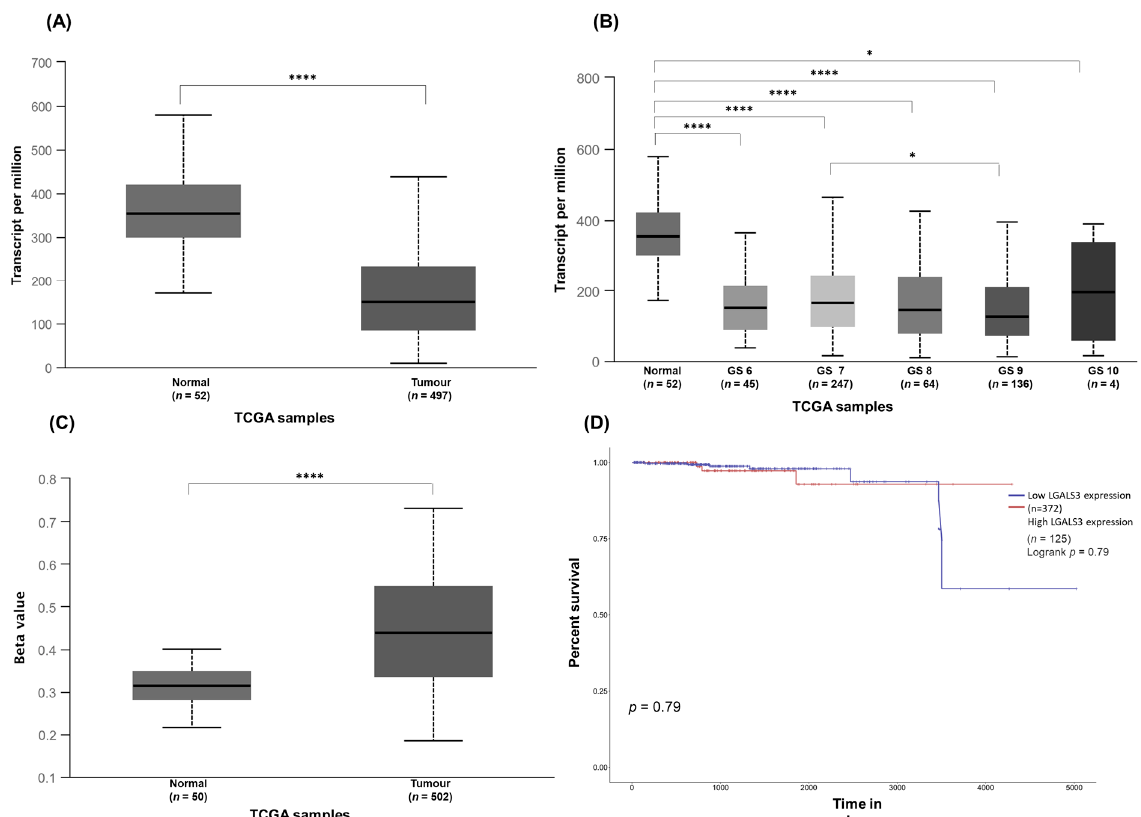
Figure 6. UALCAN analysis of: Gal-3 expression in normal and tumour prostate tissues from TCGA PCa cohorts ( A ), in normal and tumour prostate tissues with different GSs ( B ), Gal-3 promoter methylation levels in normal and tumour prostate tissues from TCGA PCa cohorts ( C ), impact of Gal-3 expression on PCa patient survival ( D ). (* p < 0.05; **** p < 0.0001).